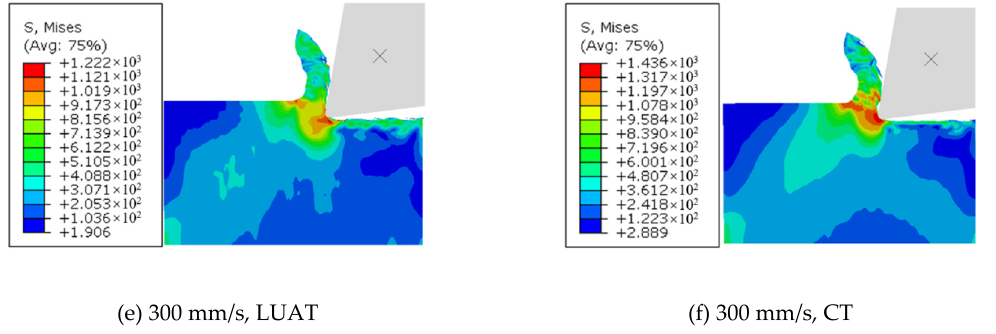
Figure 13. Maximum von Mises stress of LUAT and CT. ( a ) 100 mm / s, LUAT ( b ) 100 mm / s, CT; ( c ) 200 mm / s, LUAT ( d ) 200 mm / s, CT; ( e ) 300 mm / s, LUAT ( f ) 300 mm / s, CT.